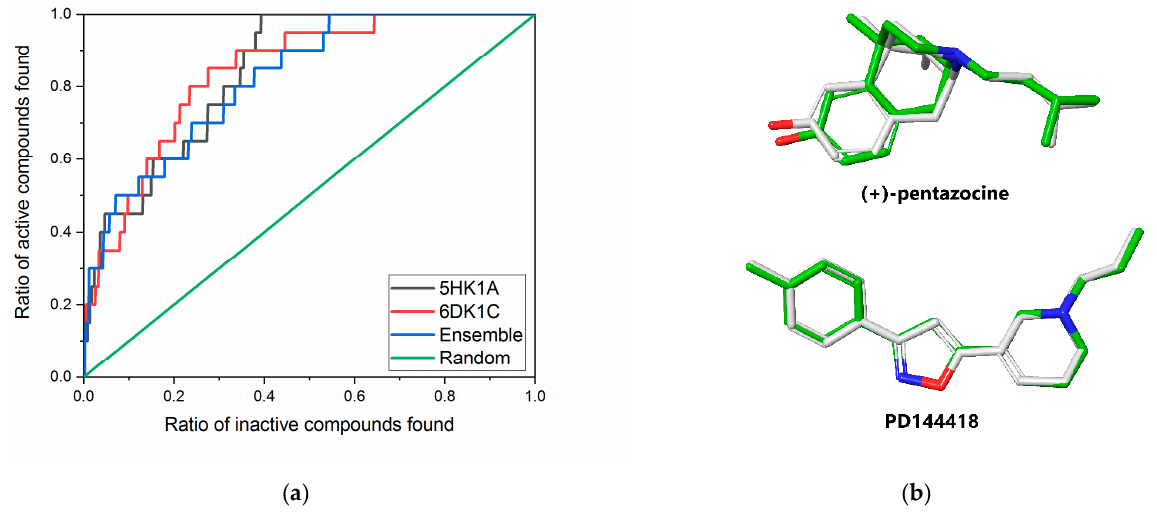
Figure 2. ( a ) Global performance of ensemble docking characterized by the ROC-curve for 5HK1A (black), 6DK1C (red) and ensemble (blue) models compared to random selection (green). ( b ) Comparison of top ranked poses of (+)-pentazocine and PD144418 of ensemble docking (green) to their X-ray structure (gray).